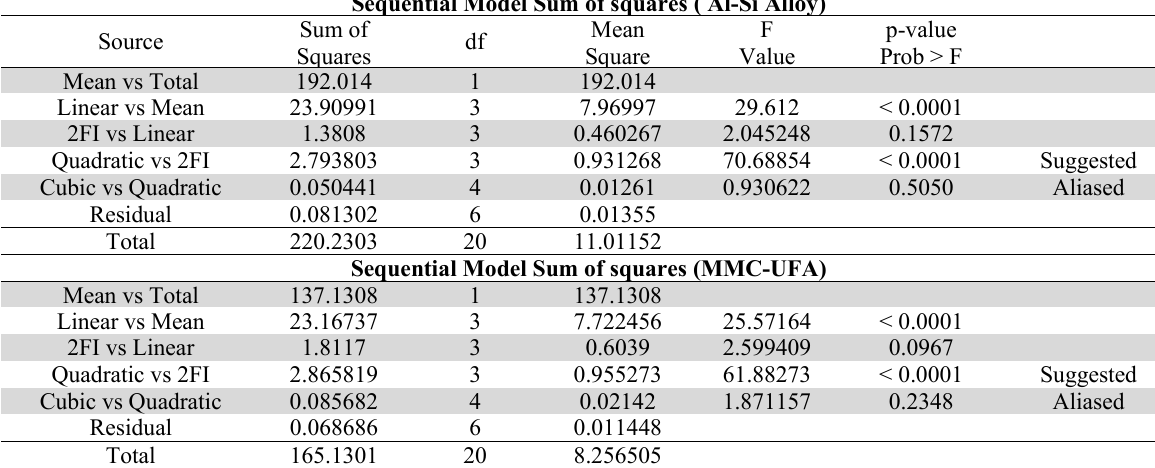
Selection of adequate model for surface roughness Sequential Model Sum of squares ( Al-Si